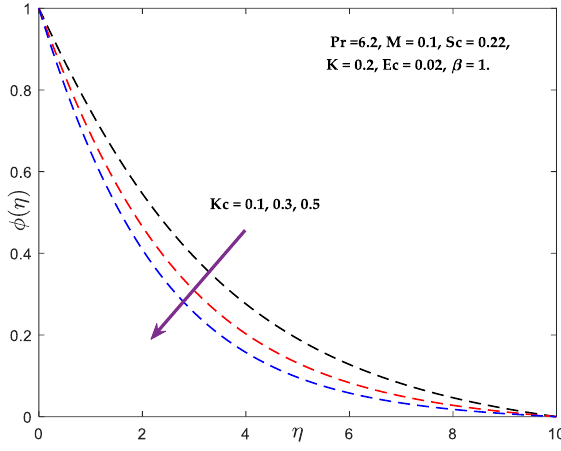
Figure 7. Concentration vs. 𝐾𝑐.